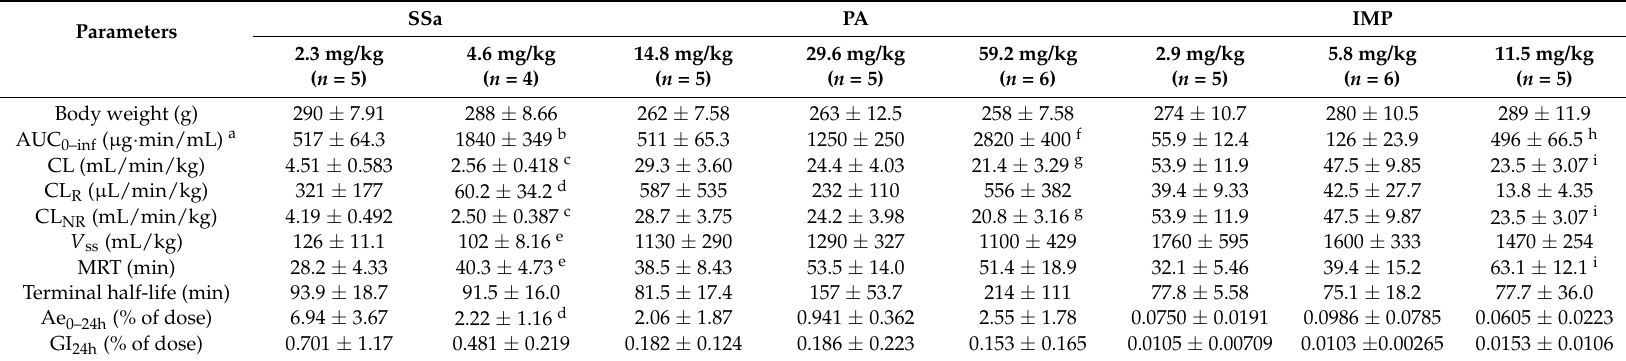
Table 1. Pharmacokinetic parameters of Saikosaponin a (SSa), paeonol (PA), and imperatorin (IMP) after intravenous administration of each drug to rats (mean ± standard deviations